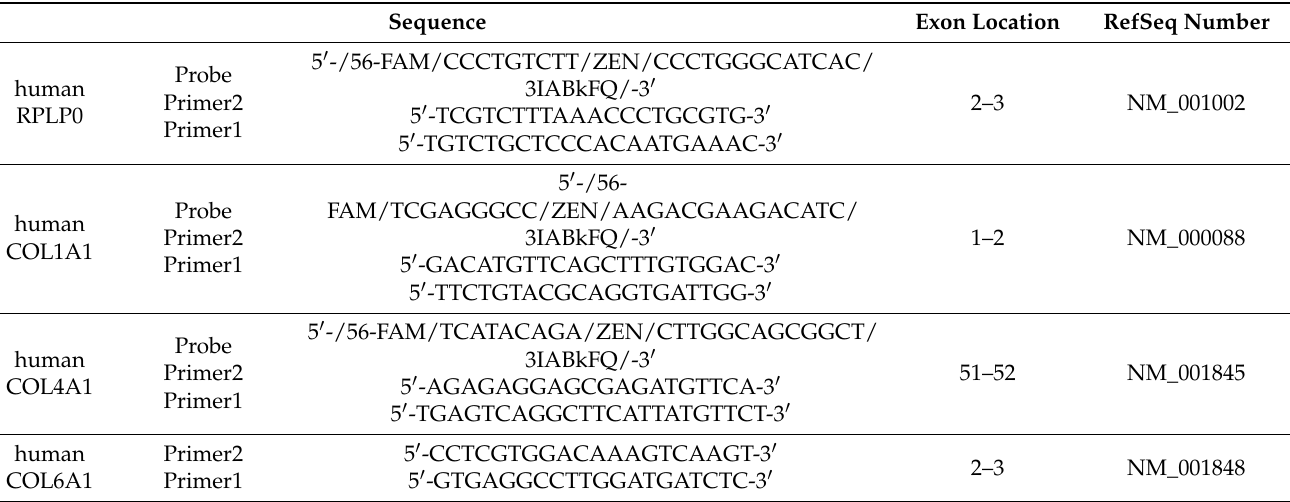
Table 1. Sequences of primers used in the